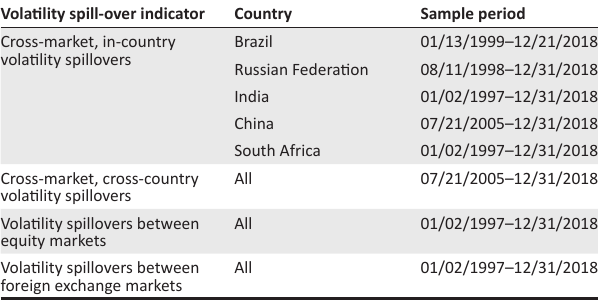
TABLE 1: Volatility spillover sample